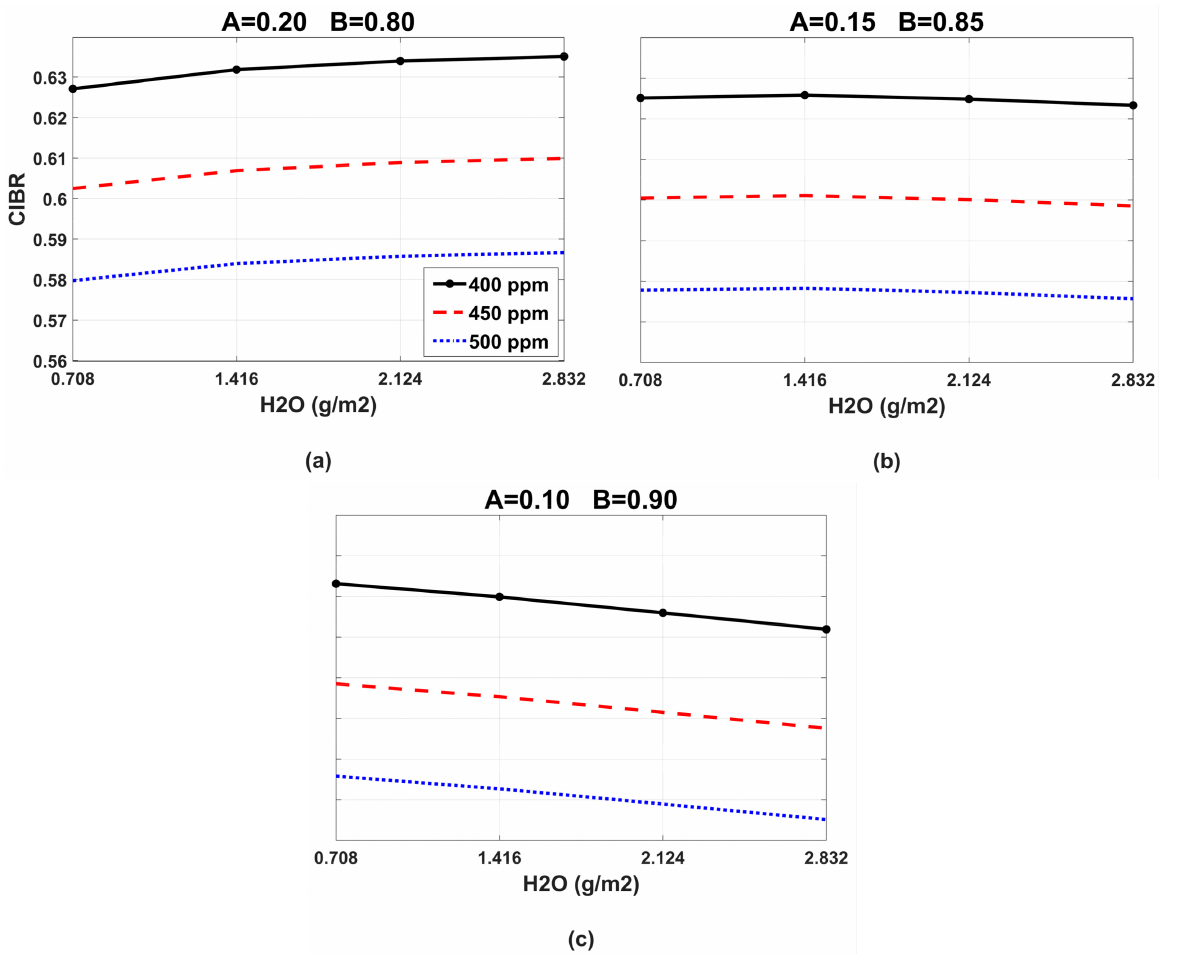
Figure 4. CIBR index simulations for three different combinations of A and B weight coefficients: A = 0.20, B = 0.80 ( a ); A = 0.15, B = 0.85 ( b ); A = 0.10, B = 0.90 ( c